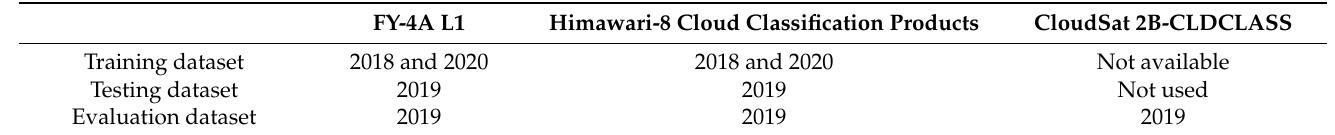
Table 2. Distribution of data. FY-4A